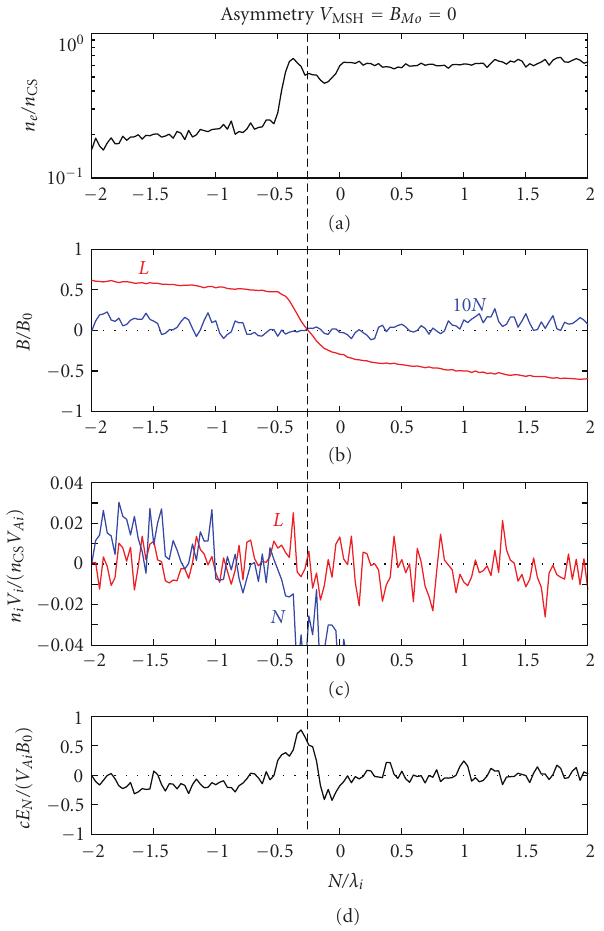
Figure 5: One-dimensionalcuts of various parameters along the N - axis at the X-line position (along the red arrow shown in Figure 4). From top to bottom, (a) n e , (b) B L (red) and B N (blue, multiplied by 10), (c) n i V iL (red) and n i V iN (blue), and (d) E N , respectively. The dashed line at X N = − 0 . 25 indicates the X-line position (where B L = 0 in Panel